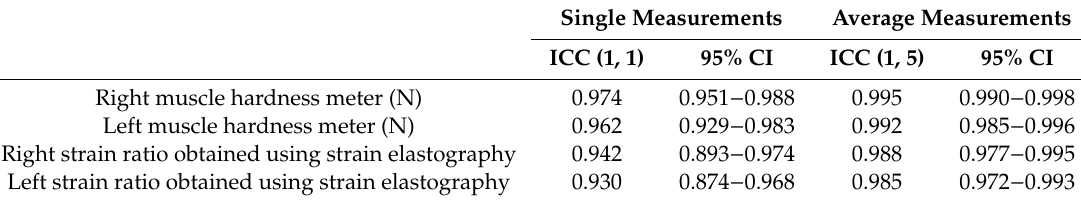
Table 2. Intra-tester reliability of upper trapezius hardness value.